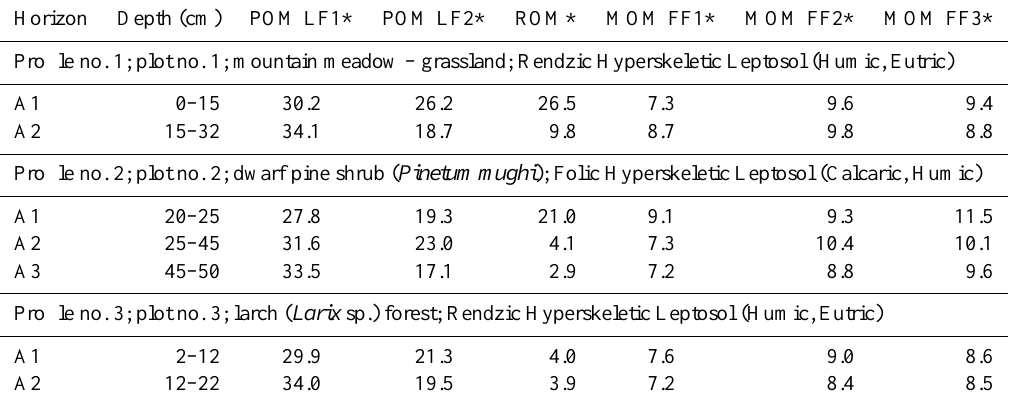
Table 5. C / N ratio in fractions. Horizon Depth (cm) POM LF1* POM LF2* ROM* MOM FF1* MOM FF2* Profile no. 1; plot no. 1; mountain meadow – grassland; Rendzic Hyperskeletic Leptosol (Humic,